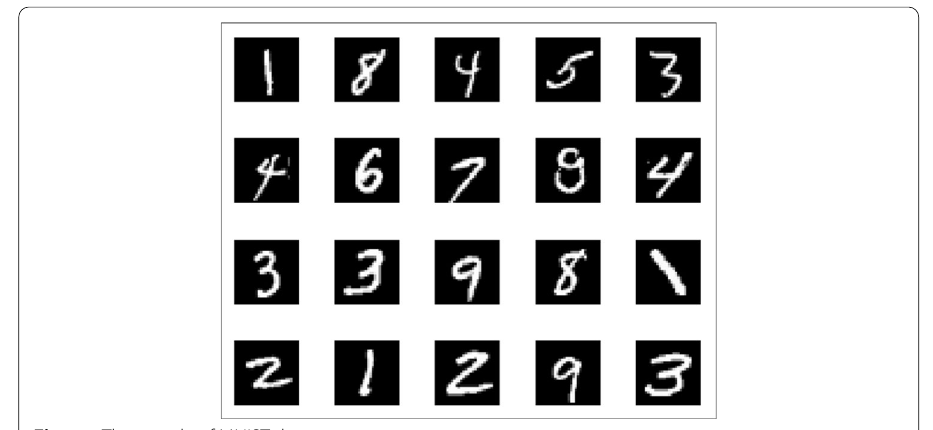
Fig. 11 The sample of MNIST dataset